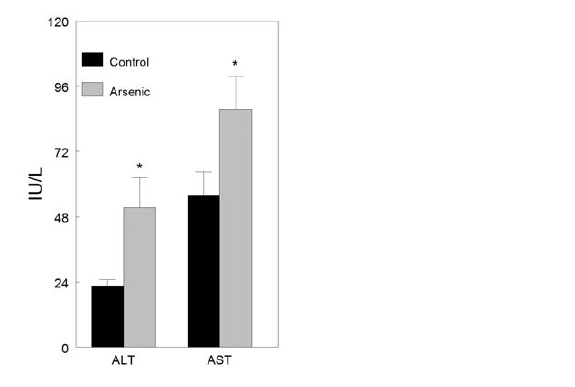
Figure 8. Plasma ALT and AST in arsenic-exposed and - unexposed PND70 ApoE-knockout mice. Mean 6 S.E. n=8 2 9 (*p , 0.026; # p=0.056).